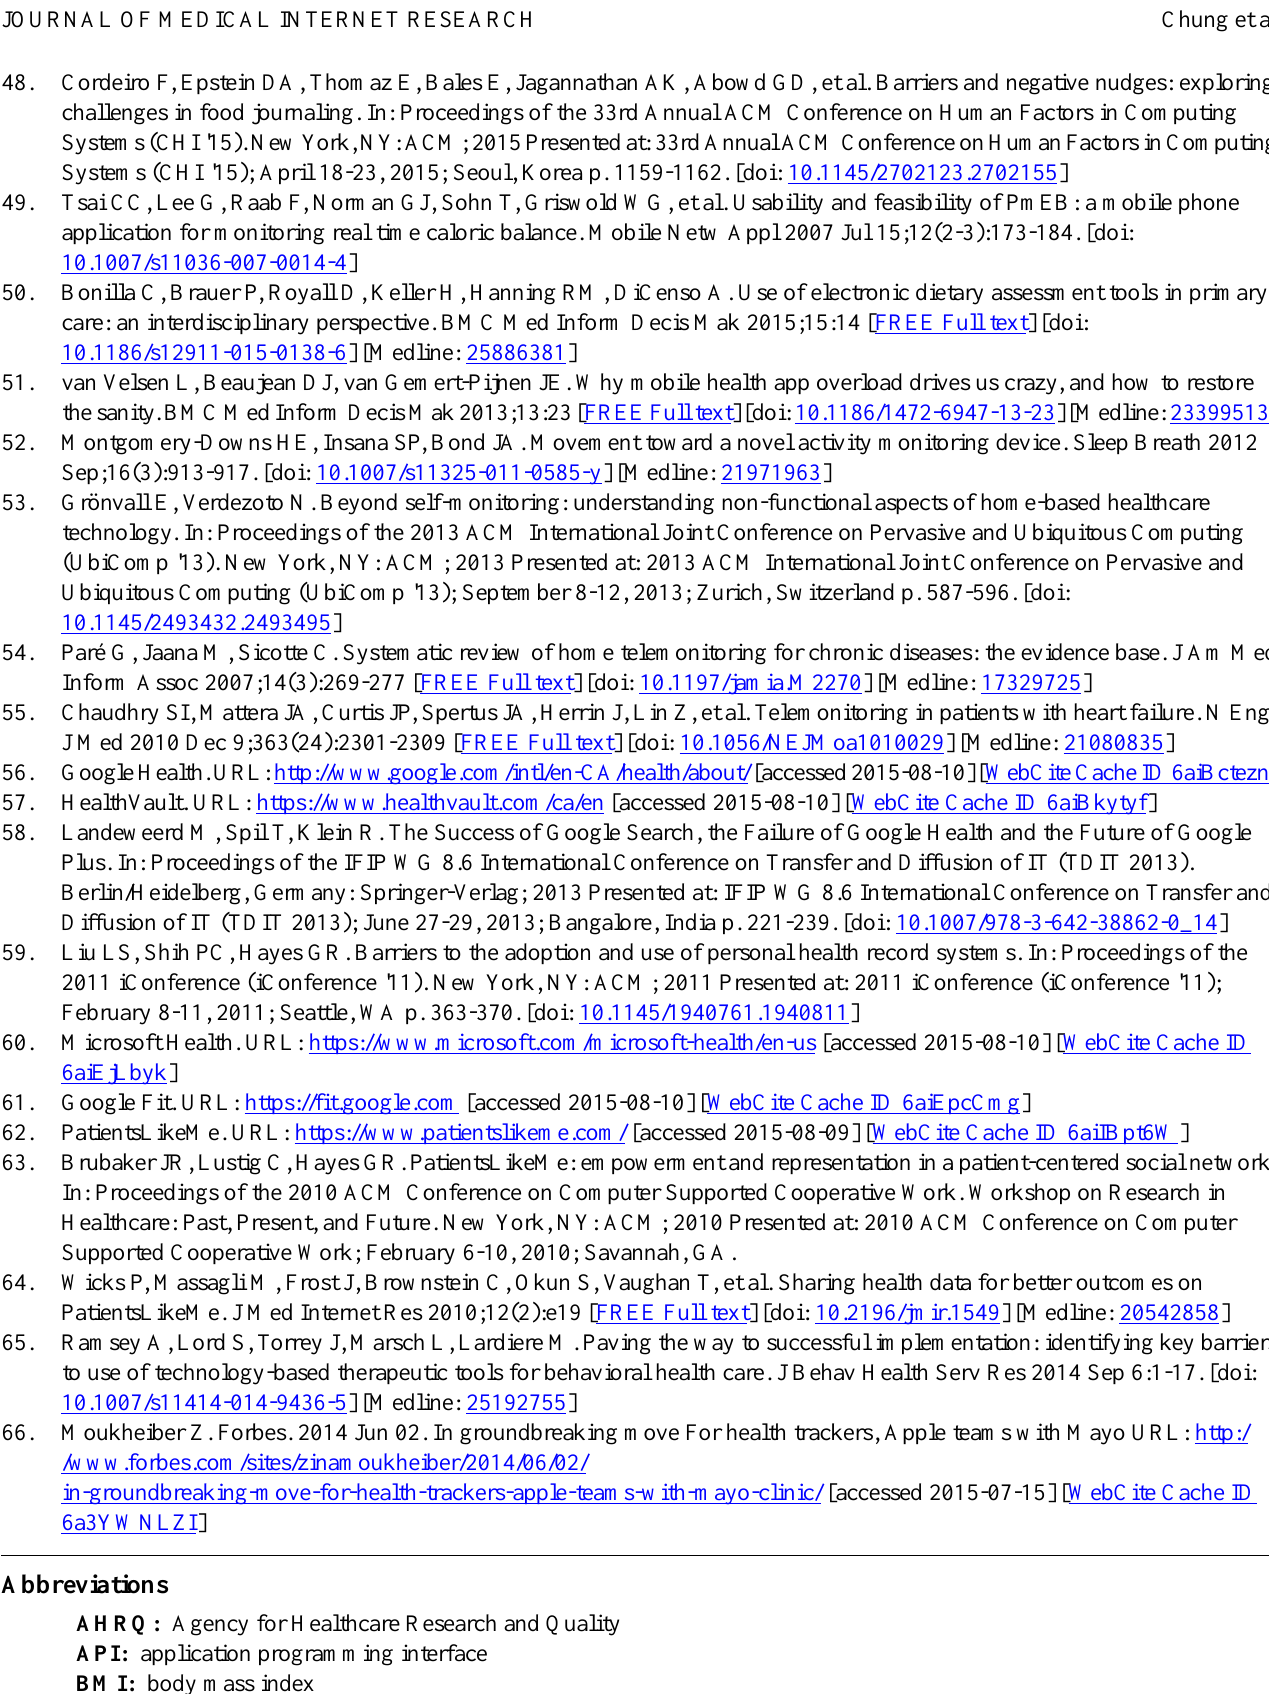
IBS: irritable bowel syndrome NSF: National Science